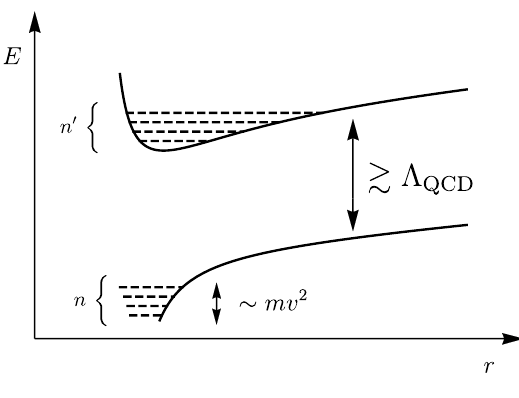
Figure 1 . Schematic distribution of energy levels associated with a heavy quark-antiquark pair and its (cid:12)rst gluonic excitation with respect to the corresponding static